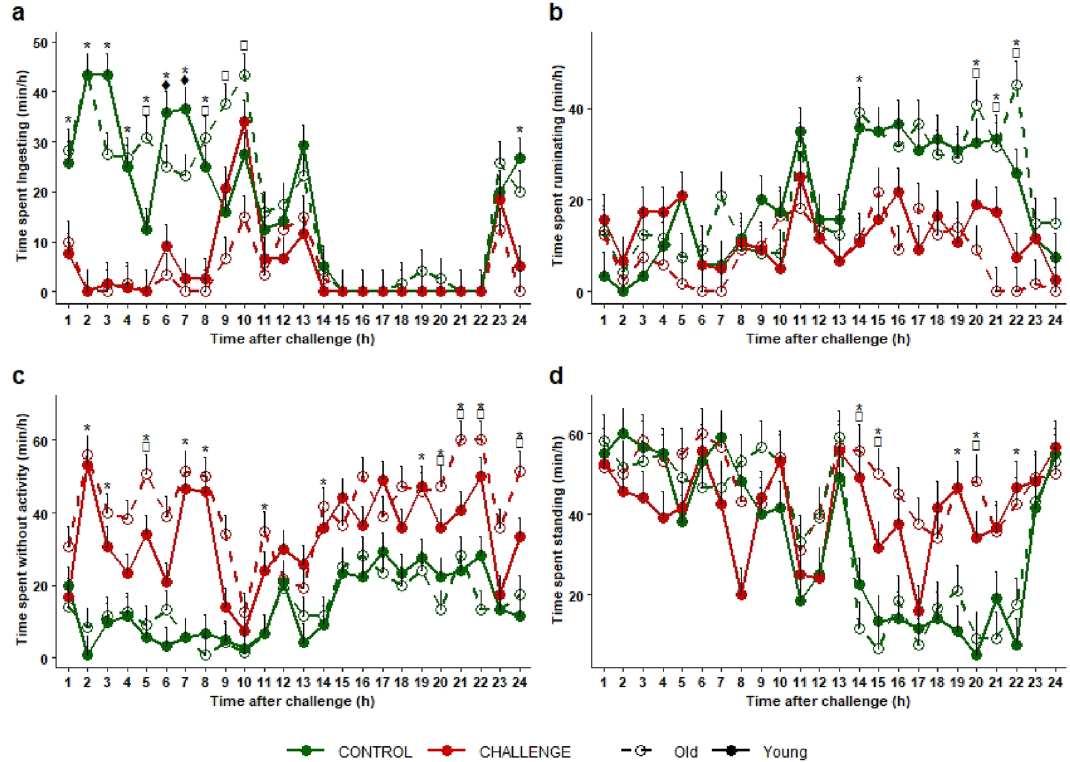
Figure 8. Changes in time spent ( a ) ingesting, ( b ) ruminating, ( c ) without activity, and ( d ) standing up in minutes per hour in 6 old (white dots and hatched lines) and 6 young (filled dots and solid lines) Holstein cows during 24 h (hourly analysis) before intravenous injection of LPS (T0; 9:30 am) (0.5 µg/kg of BW) (CONTROL, in green) and after (CHALLENGE, in red). Data are presented as least squares means (± SE). Means with * indicate significant differences between timepoints and situations (CHALLENGE vs. CONTROL) regardless of age, with ♦ for young cows only, and □ for old cows only ( p ≤